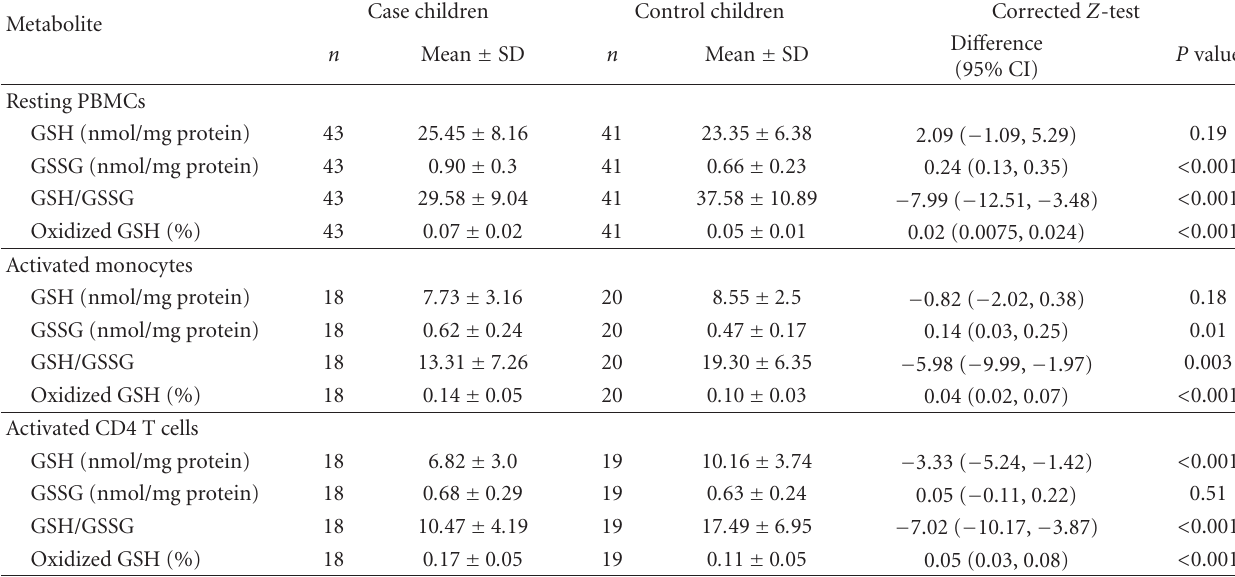
Table 2: Intracellular glutathione redox status in resting PBMCs and activated monocytes and CD4 T cells.